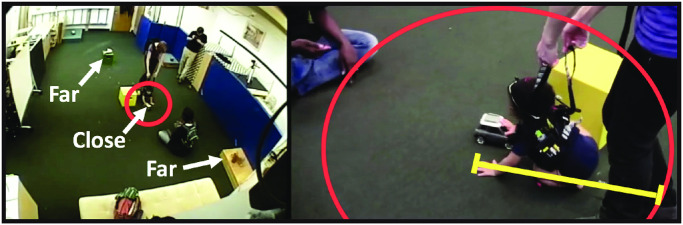
Distance coding.Coders went through third-person view videos to score toy distance. Toys within the reference distance (yellow line) were coded as close to the infant, whereas toys beyond the reference distance were coded as far.